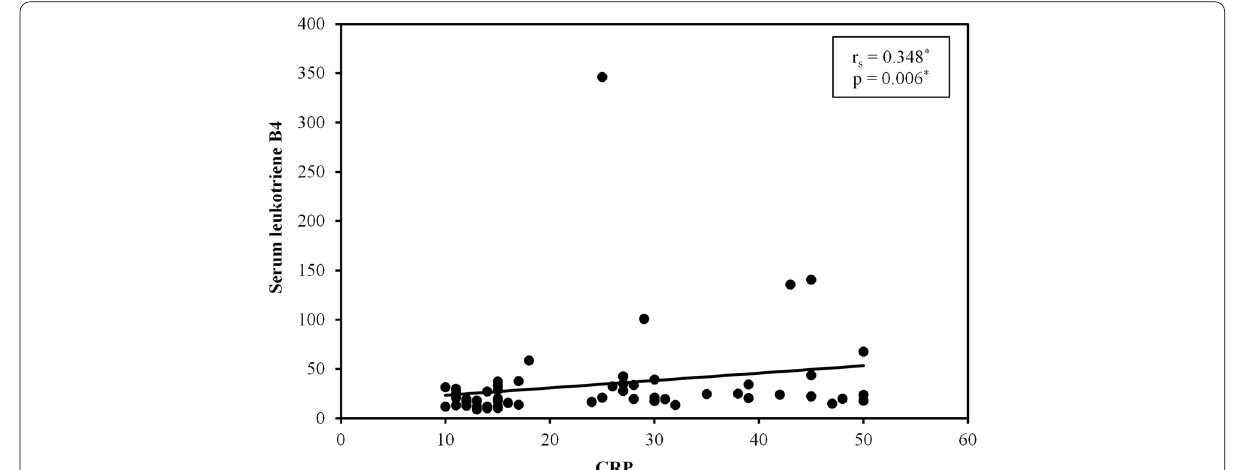
Fig. 2 Correlation between serum leukotriene B4 and CRP in total cases ( n